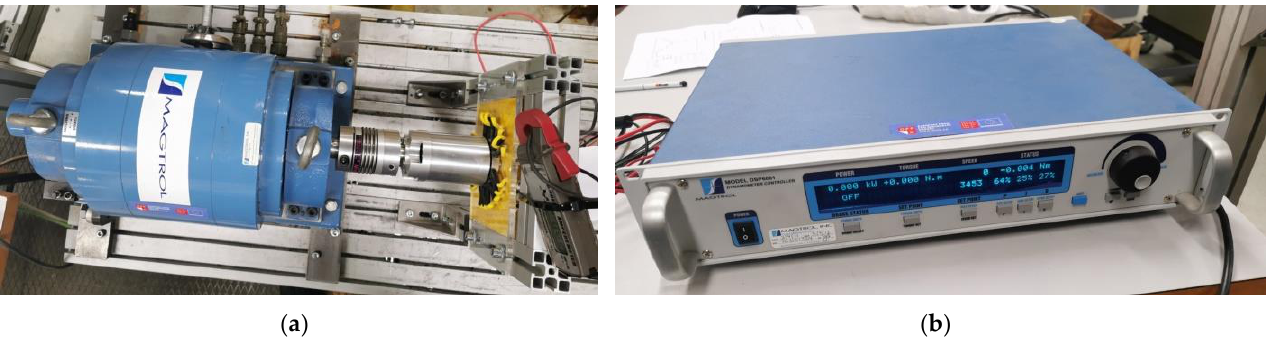
Figure 8. Experimental setup—dynamometer ( a ) and its controller ( b ).